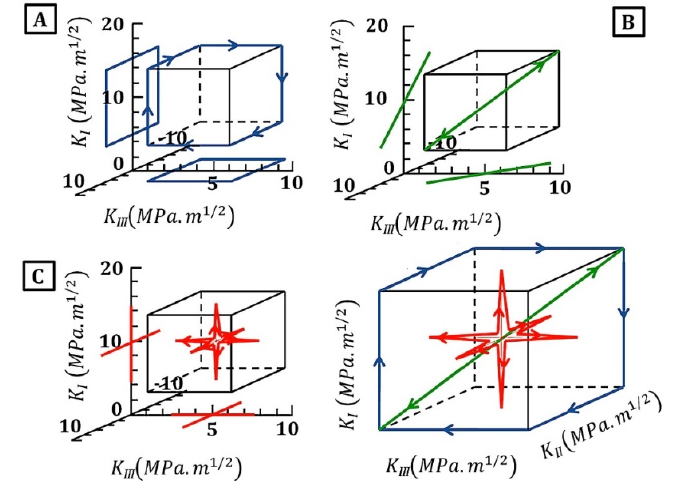
Figure 4: Loading cases applied in mixed mode I+II+III conditions. A – « Cube » load path, B – « Proportional » load path, C – « Star» load